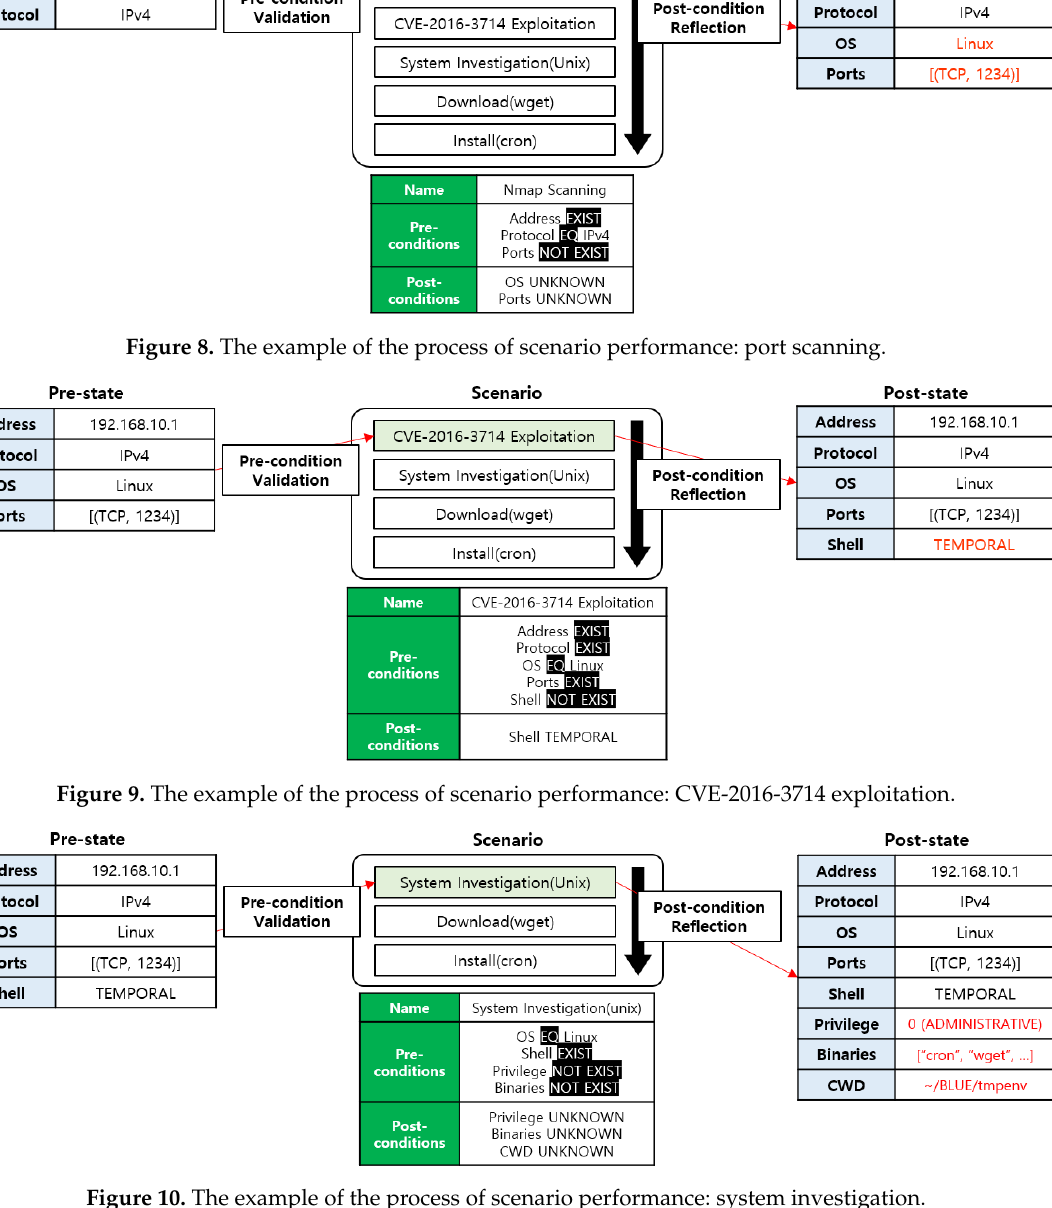
Figure 10. The example of the process of scenario performance: system